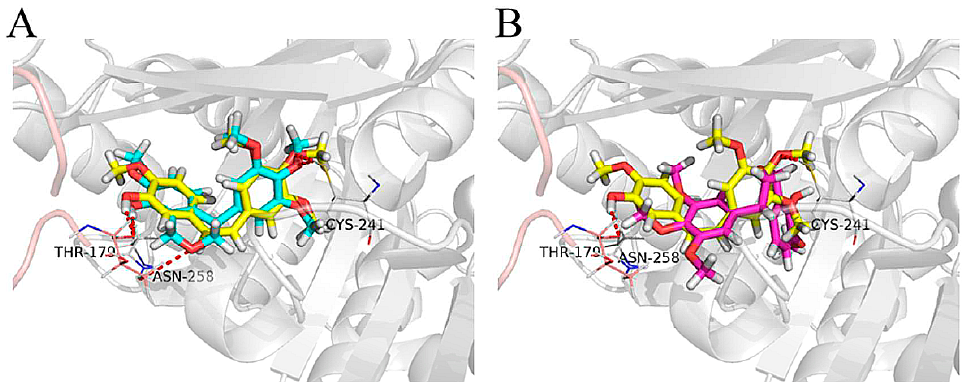
Figure 15. Proposed binding models for two 4-arylisochromenes enantiomers ( 35 ) with tubulin (PDB code: 5lyj). ( A ) Combretastatin (shown in yellow); ( R )-enantiomer (shown in blue). ( B ) CA-4 (shown in yellow); ( S )-( − )-enantiomer (shown in violet). Reprinted with permission from Ref [102]. Copyright ©2018, American Chemical Society.